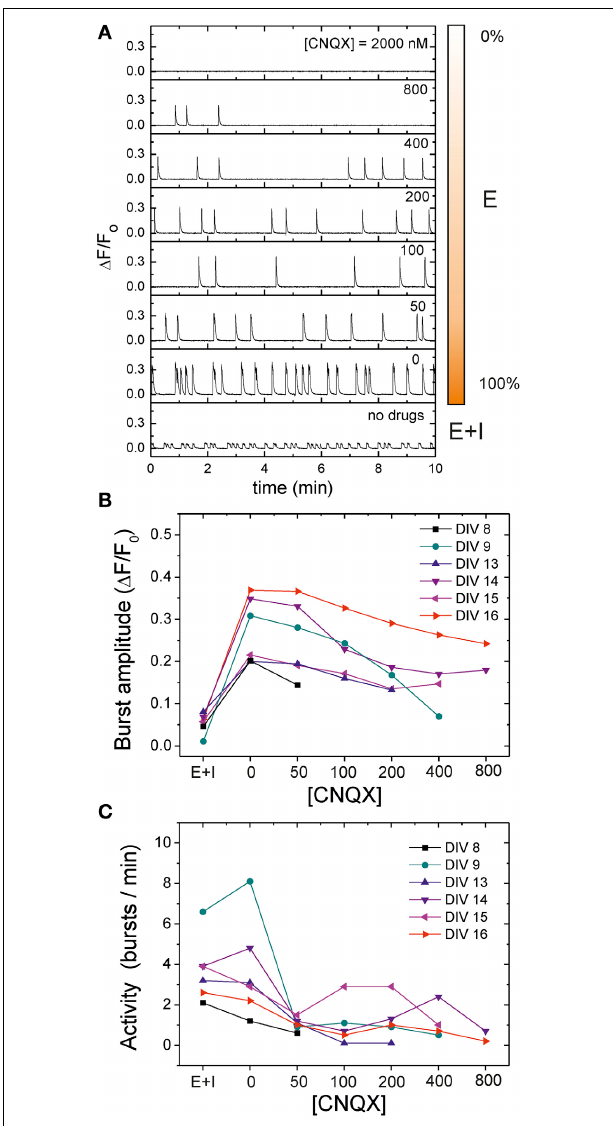
FIGURE 5 | Network disintegration through CNQX in an “E-only” network. (A) Examples of spontaneous activity traces for 7 concentrations of the AMPA-excitatory antagonist CNQX, in a mature culture at DIV 16. During the disintegration protocol inhibitory synapses are silenced through application of 40 μ M bicuculine. NMDA synapses are also blocked by 20 μ M APV. Fluorescence traces are compared with the unperturbed, “E + I” case. For [ CNQX ] = 0, activity is characterized by high amplitudes and large interbust intervals (IBIs) compared to the “E + I” case. As CNQX is applied, both the bursting amplitude and timing change, until all bursting activity disappears for large [CNQX]. The bar at the right side of the traces illustrates the relative strength of the excitatory connectivity. (B) Population-averaged bursting amplitudes during the disintegration process and for different culture ages, showing the steady decay in bursting amplitudes as CNQX increases. (C) Average network activity, quantified as 1 / (cid:6) IBI (cid:7) , during disintegration. Young cultures decrease in activity and become silent at lower CNQX concentrations than maturer cultures. Maturer cultures show a mixed behavior in which activity initially decreases, to abruptly increase for some CNQX concentrations. The data for DIV 16 shown in panels (B) and (C) correspond to the exemplary traces of panel (A)